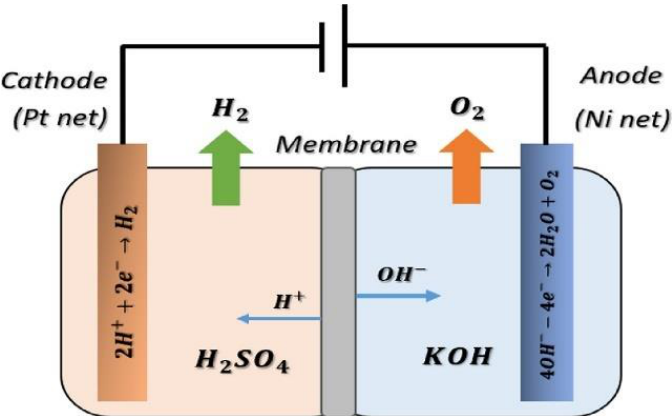
Figure 11. Acidic-alkaline amphoteric electrolysis. Reproduced with permission from [34].